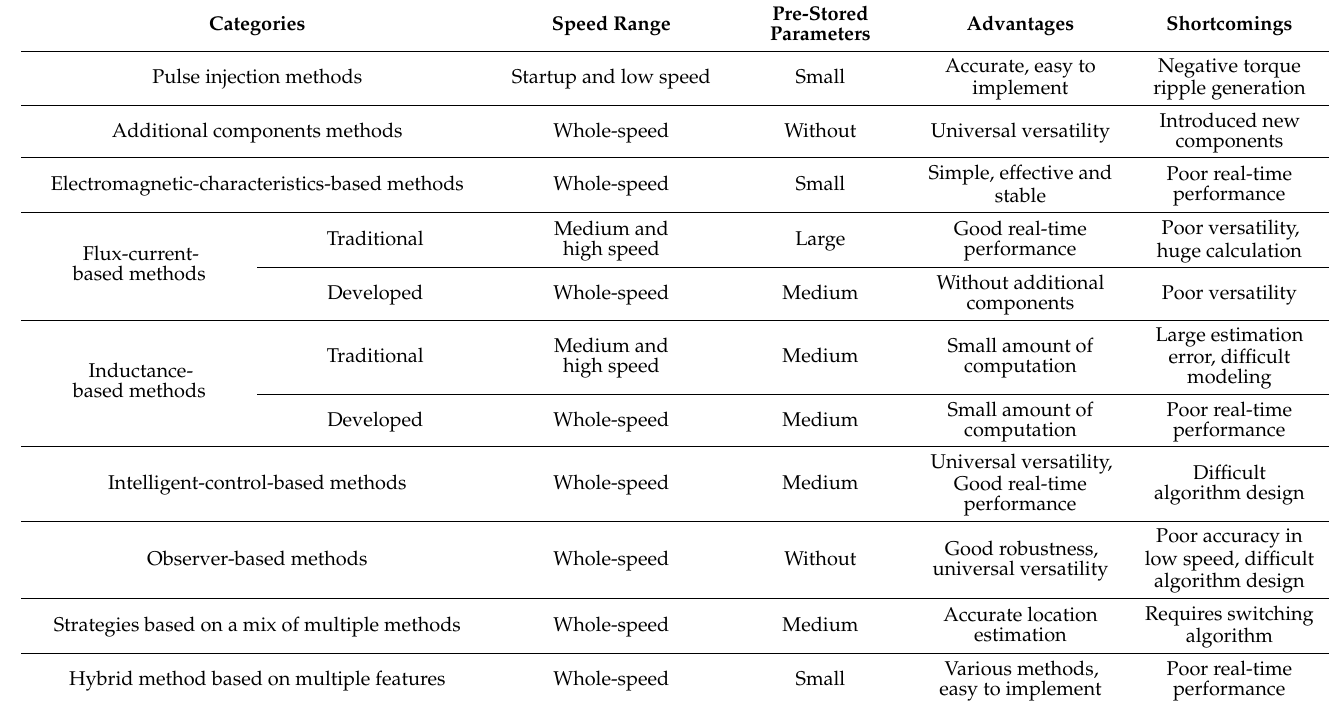
Table 2. Comparison of the various sensorless